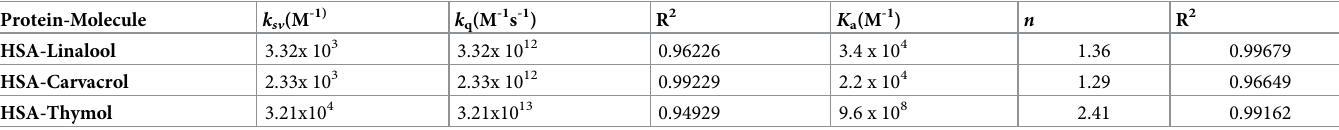
Table 2. The value of Stern-Volmer quenching constant ( k sv ) and quenching rate constant ( k q ), binding constant ( K a ) and number of binding site ( n ) in the absence and presence of thymol, carvacrol and linalool following binding to HSA.